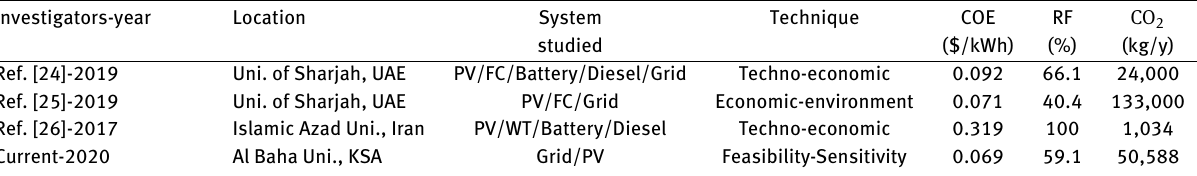
Table 4: Optimization results of grid-connected HRES systems for Al Baha University. System Grid/PV Grid/PV/WT Table 5: Optimization results of grid-connected HRES systems for University of Jeddah. System Grid/PV